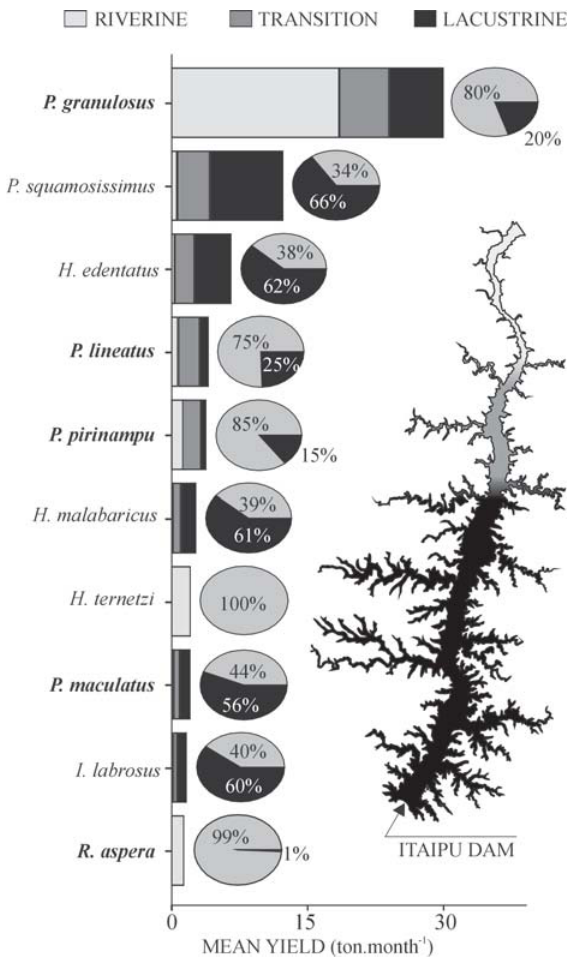
Fig. 5. Yield proportions of migratory (boldface) and non- migratory species in the commercial fishery conducted in the different zones of Itaipu Reservoir, during the years 2001 through 2003 (the gray tone in the pie charts refers to riverine plus transition